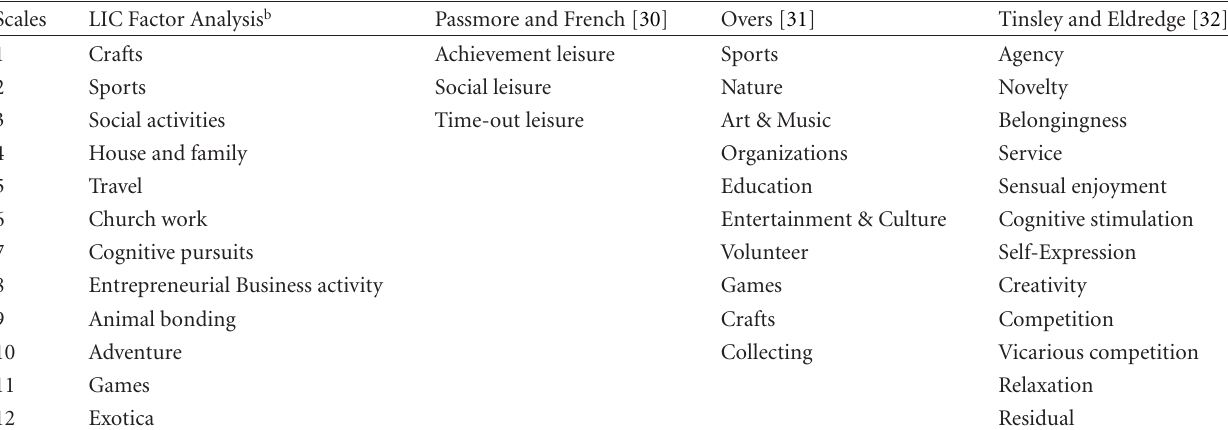
a The three literature-based taxonomies are drawn from Mokhtaria, Salomon, and Handy (2004). b Twelve scales are based on our factor analysis of the LIC